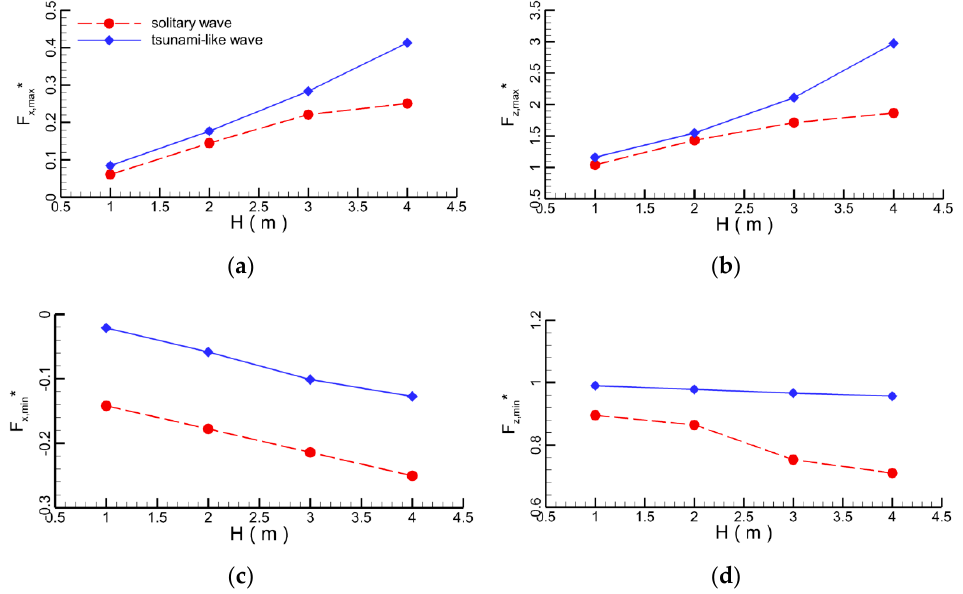
Figure 22. Plots of maximum hydrodynamic forces at the pipeline as a function of wave height; ( a ) maximum horizontal force F x,max *; ( b ) maximum vertical force F z,max *; ( c ) minimum horizontal force F x,min *; ( d ) minimum vertical force F z,min *.